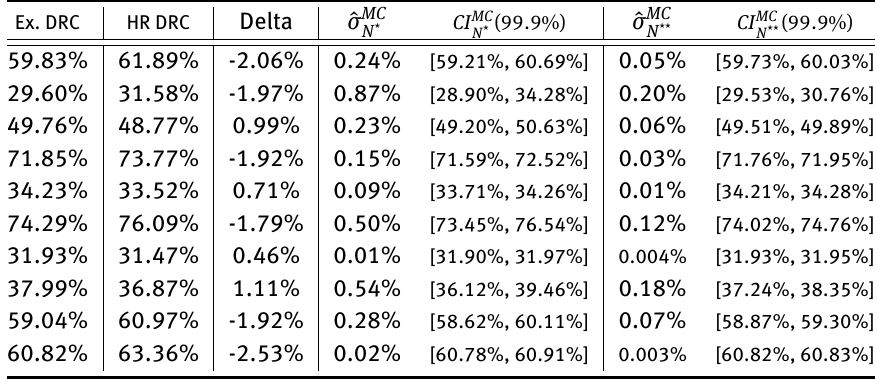
Table 3: Table containing DRC got from the HR model and the exact algorithm for a J * = 18 dimensional portfolio, where Delta = HR DRC − Exact DRC. The ˆ σ N * and ˆ σ N ** are estimated by equation (13) with N * = 10, 000 and N ** = 100, 000 , the CI are centered in the DRC values obtained by the MC